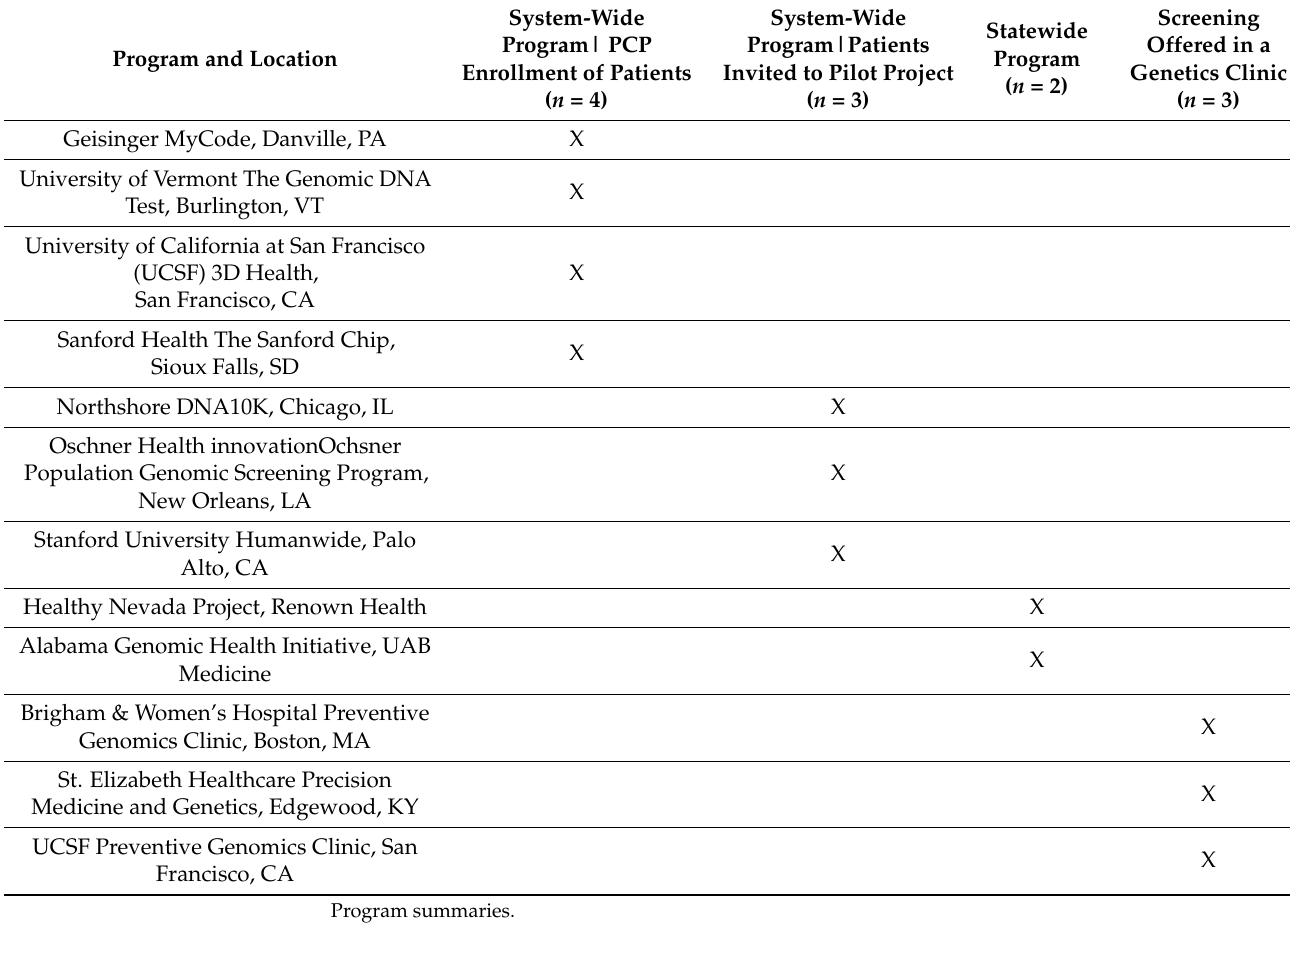
Table 2. Genomic Screening Programs in 4 Categories.